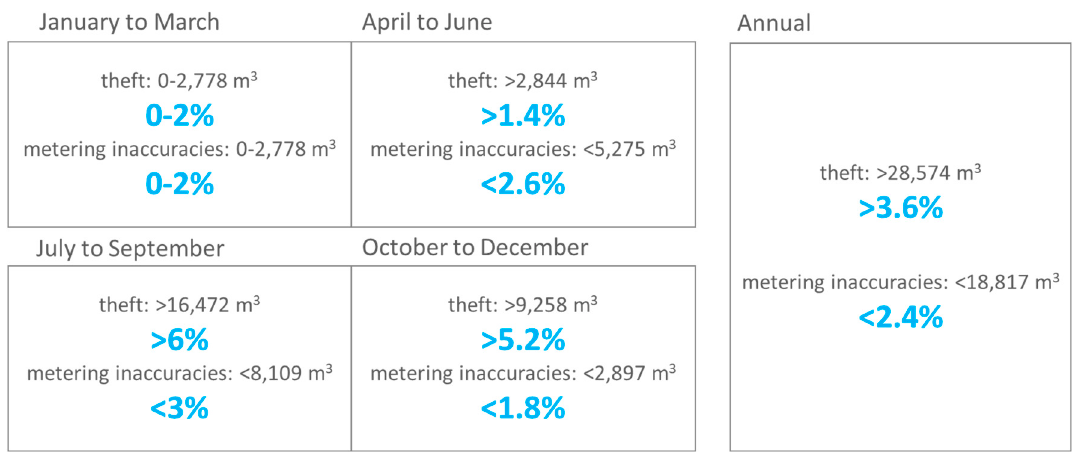
Figure 16. Annual component analysis of SIV into BAC, apparent losses, real losses, revenue water and nonrevenue water (all components are also presented as percentages of SIV).